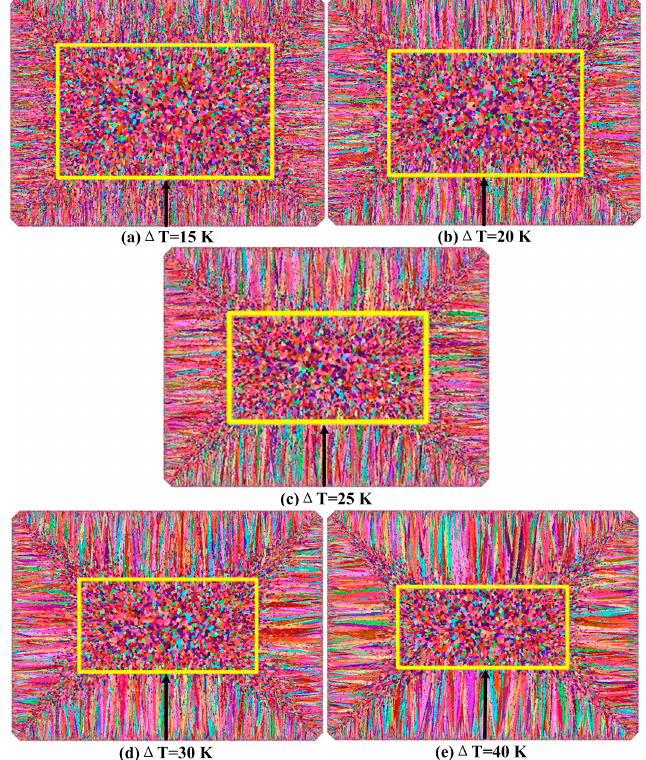
Figure 10. Solidification structure in the bloom under different superheat: ( a ) 15 K, ( b ) 20 K, ( c ) 25 K, ( d ) 30 K, ( e ) 40 K.